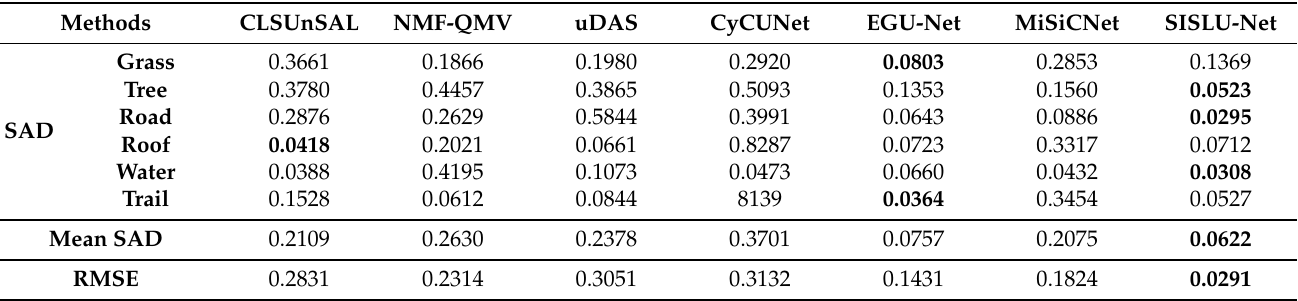
Table 10. Quantitative metrics for unmixing on the Washington DC Mall Dataset, including the SAD for each material, the mean SAD, and RMSE. The optimal values are shown in